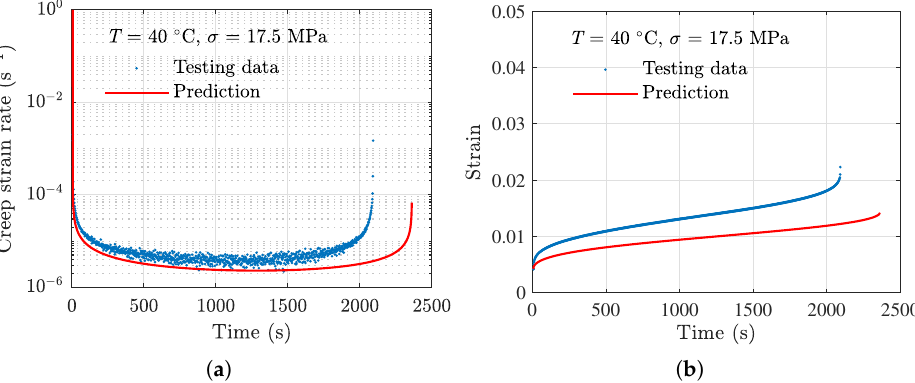
Figure 13. Comparison of the model prediction and the actual data of the validation specimen. ( a ) The creep strain rate vs. time, and ( b ) the creep strain vs. time.